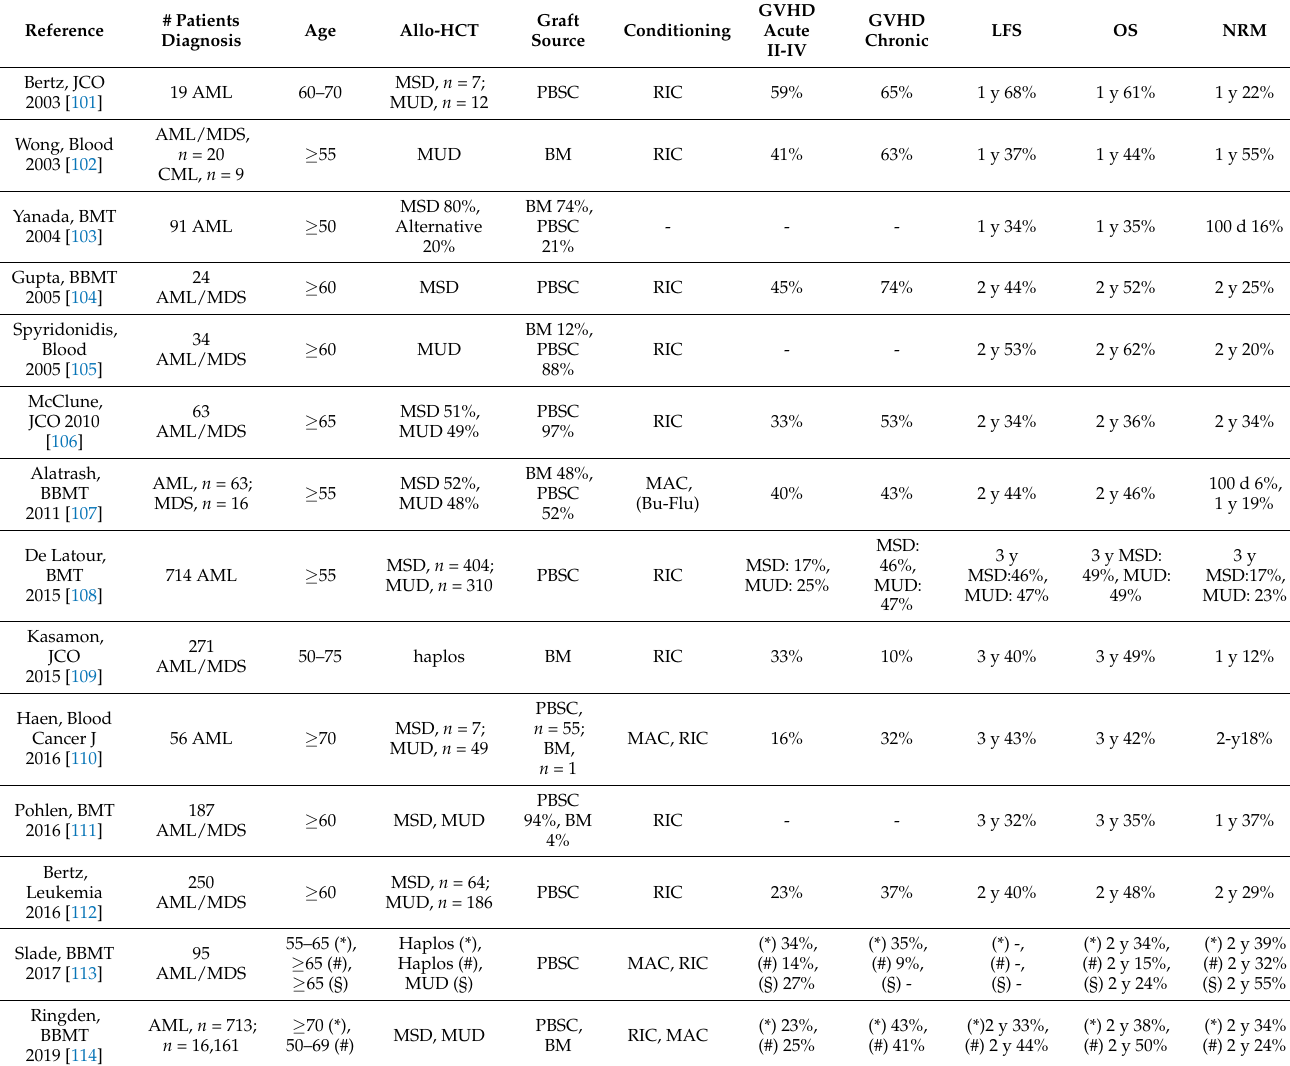
Table 2. Main studies analyzing the outcomes of older patients with AML undergoing allogeneic